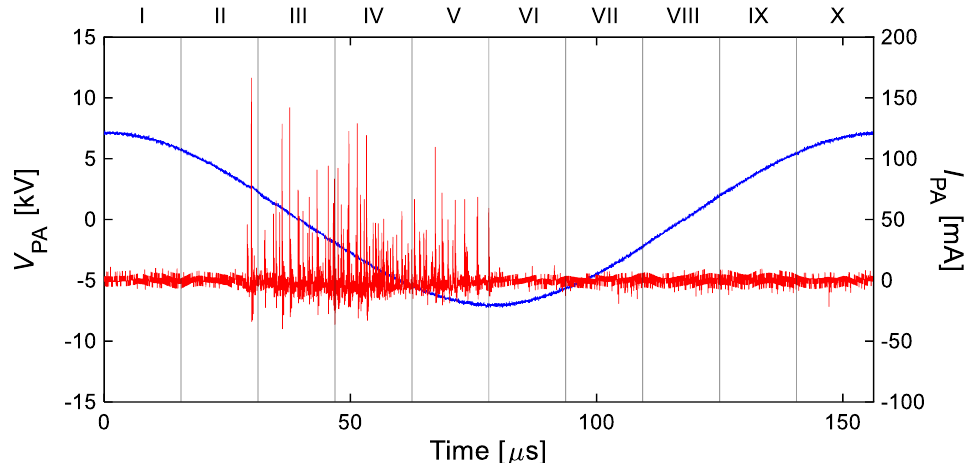
Figure 8. Measured voltage and current in one cycle ( f p = 6.4 kHz) divided into 10 sections from (I) to (X) for visualization of DBD using ICCD camera.